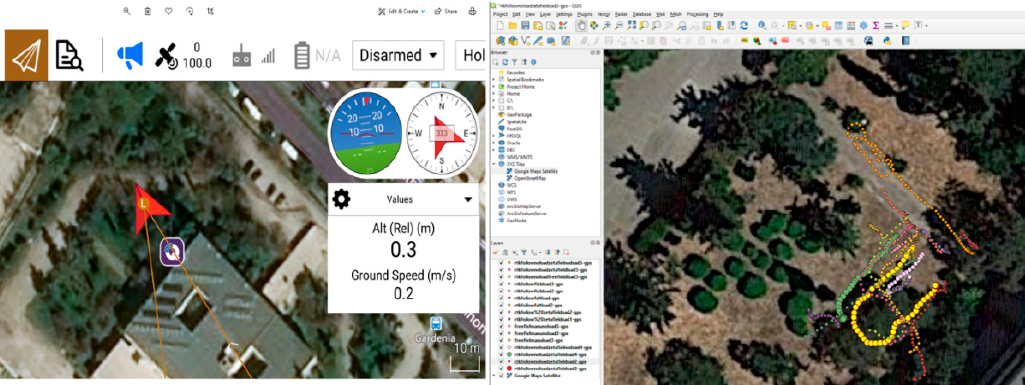
Figure 12. Environments for visualizing the position and trace of the agricultural robots: QGround Control ( left ) and the QGIS ( right ). The positioning accuracy is directly linked with the quality of the equipment being used.